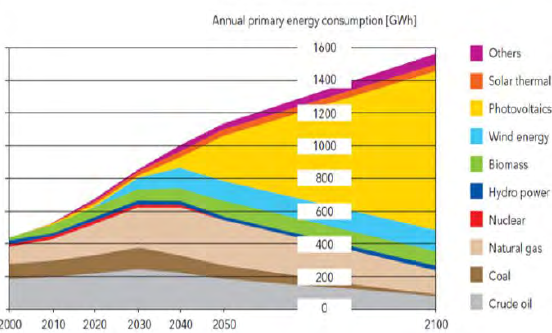
Figure 1. Global plans for demand for renewable energy resources as an alternative to fossil energy sources that face the risk of depletion over the next 100 years (Beckman, 2017)